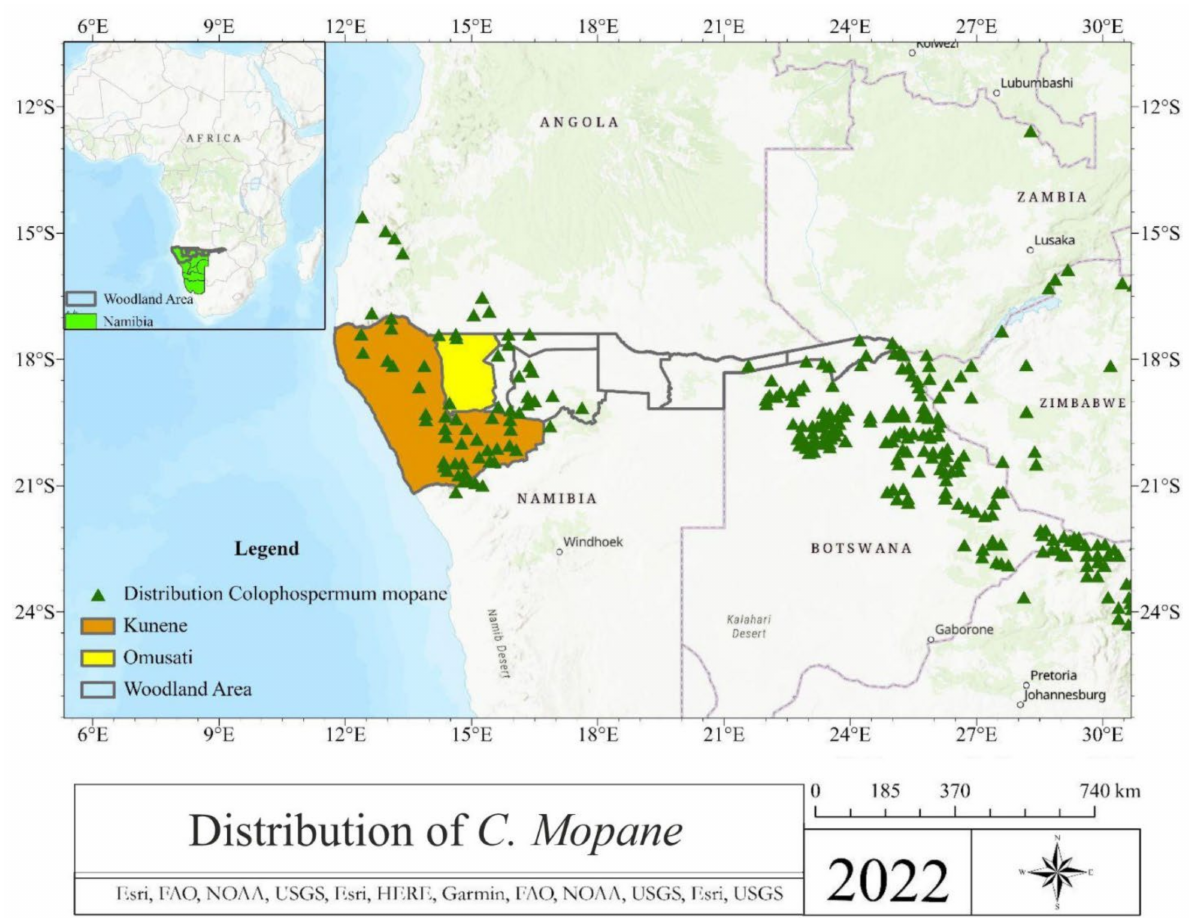
Figure 2. The distribution of C. mopane